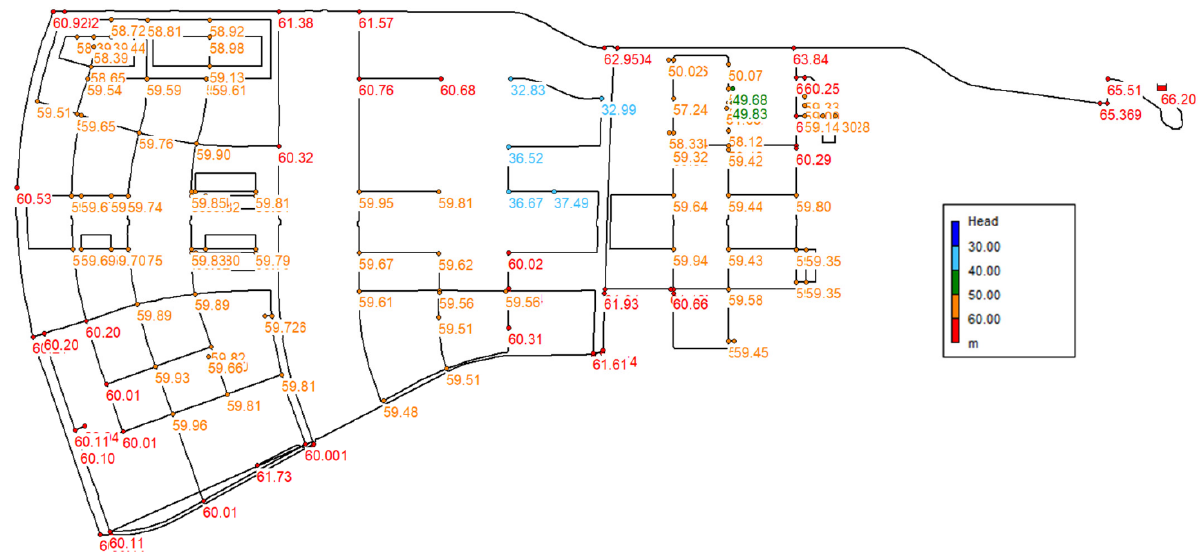
Figure 3. EPANET original model of the Cheongna WDN indicating the current head pressures. Table 3. Hydraulic characteristics of the Cheongna WDN model.